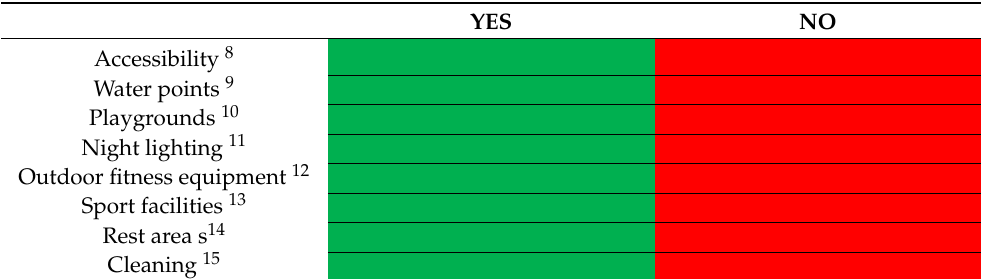
Table 2. Proposed indicators for checking the Accessibility/Facilities